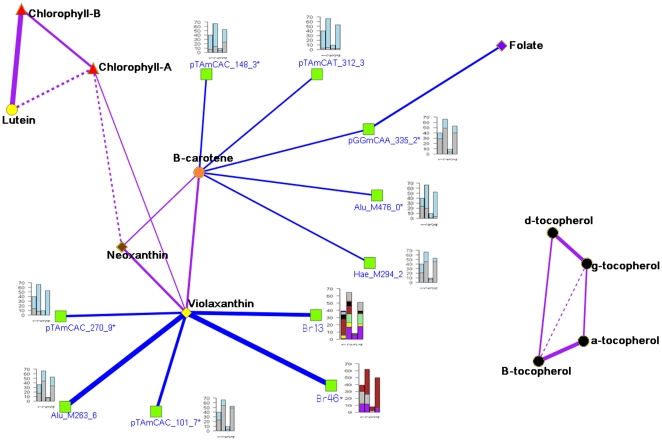
Network of partial correlation between metabolites, and
marker-metabolite association under model 4 (KQ correction).The thicker the line, the stronger the correlation and or
association. Shape and color of vertices indicate metabolites and
associated markers: β-carotenoids – round-orange;
chlorophylls – triangle-red; folate- diamond-purple; lutein-
round-yellow; neoxanthin- diamond-brown; tocopherols- round-black;
violaxanthin- diamond-yellow and associated markers (model-4)-
square-green. The allele frequency distribution of each associated
marker according to STRUCTURE sub-populations is illustrated with
barplot. Colours in barplots represent different marker alleles.
*- indicates markers that are common between model 4(KQ
correction) and RF.